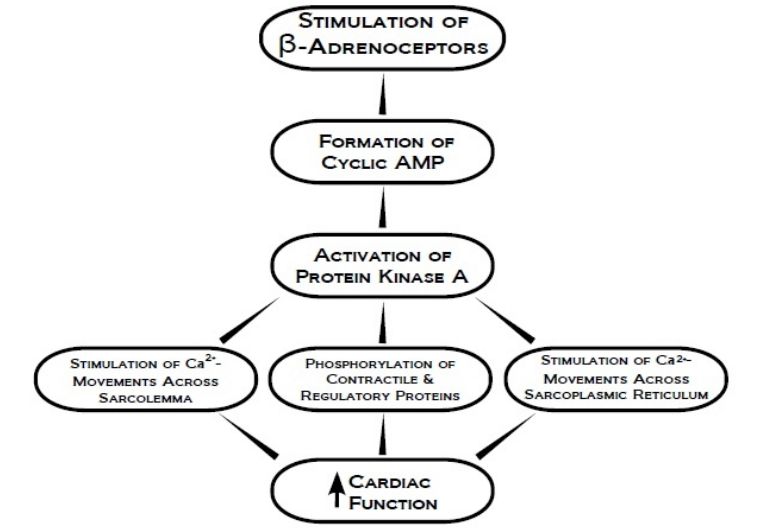
Figure 3. Modification of subcellular activities by the activation of protein kinase A for increasing cardiac